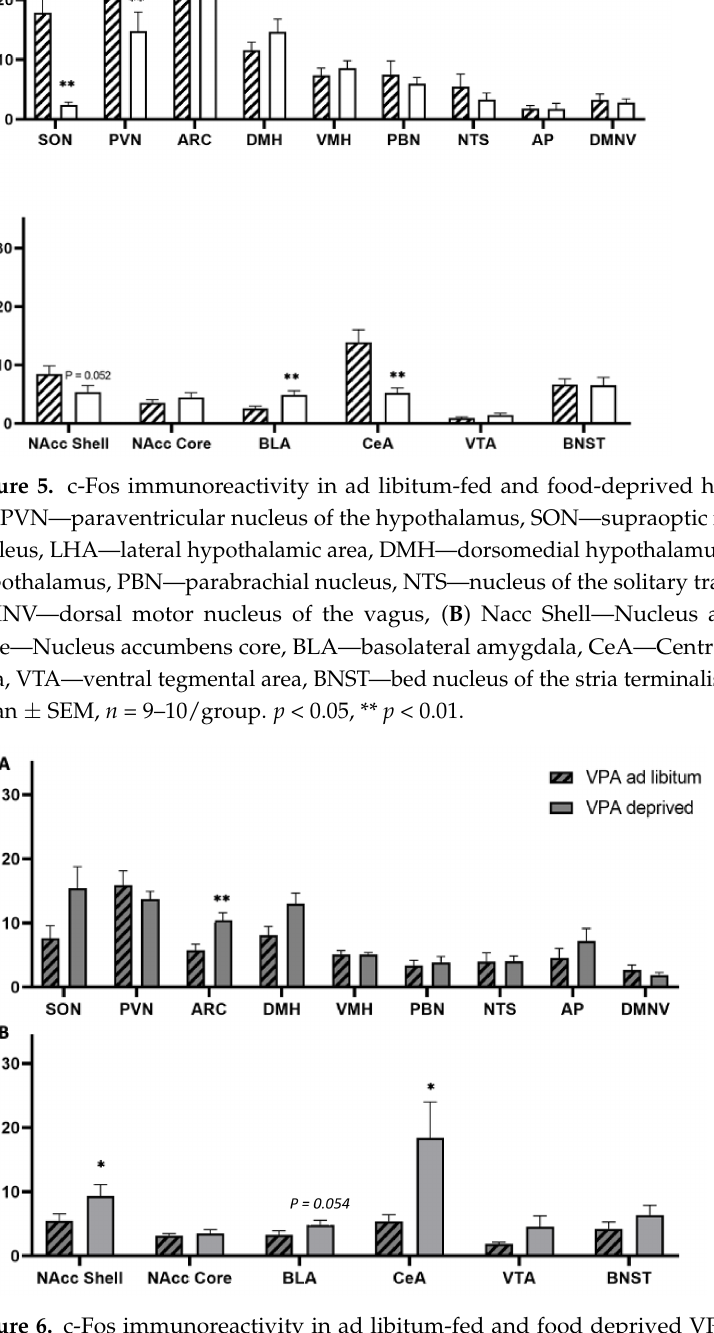
Figure 6. c-Fos immunoreactivity in ad libitum-fed and food deprived VPA animals. ( A )